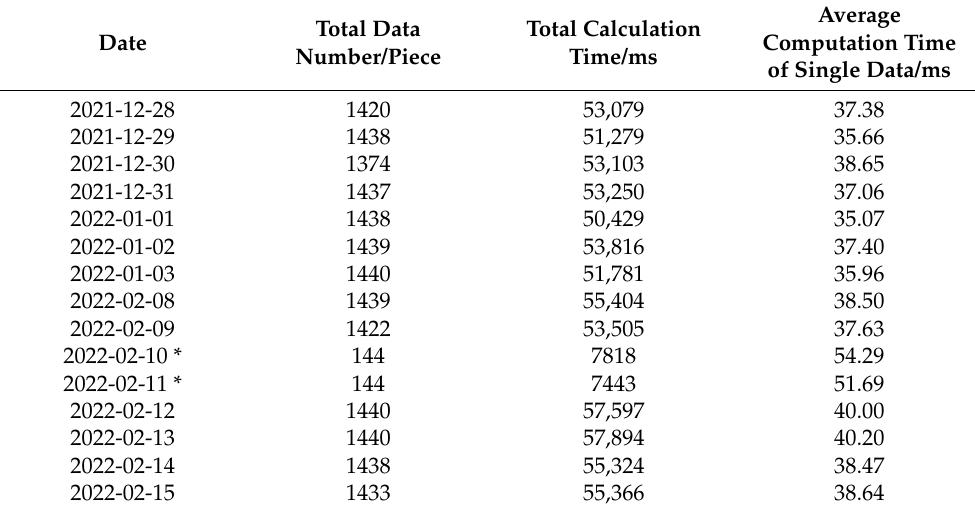
Table 9. Time-consuming results of multi-group data estimate.